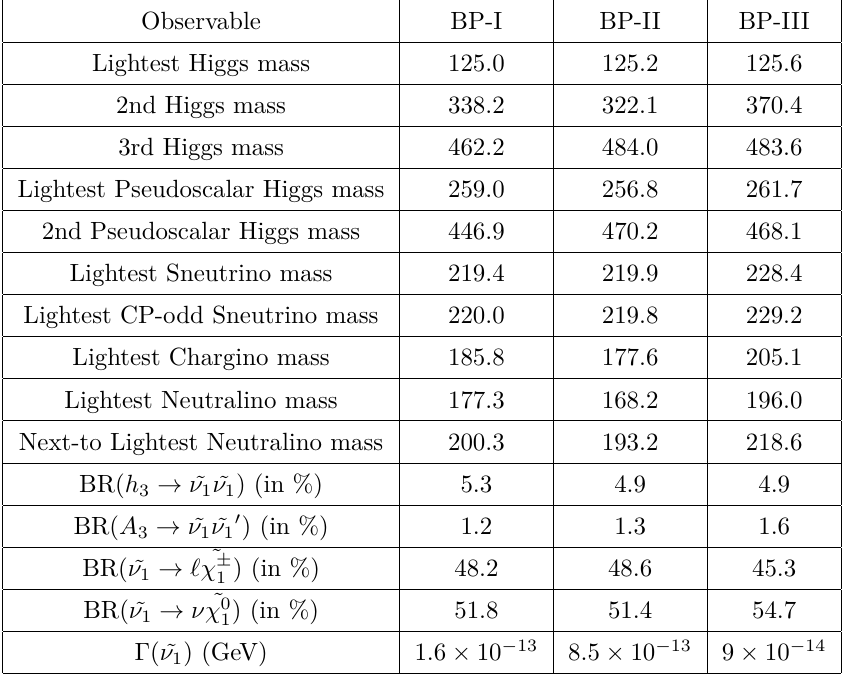
Table 1 . Details of the BPs (all the masses are in GeV). The leptonic BRs include electron, muons and